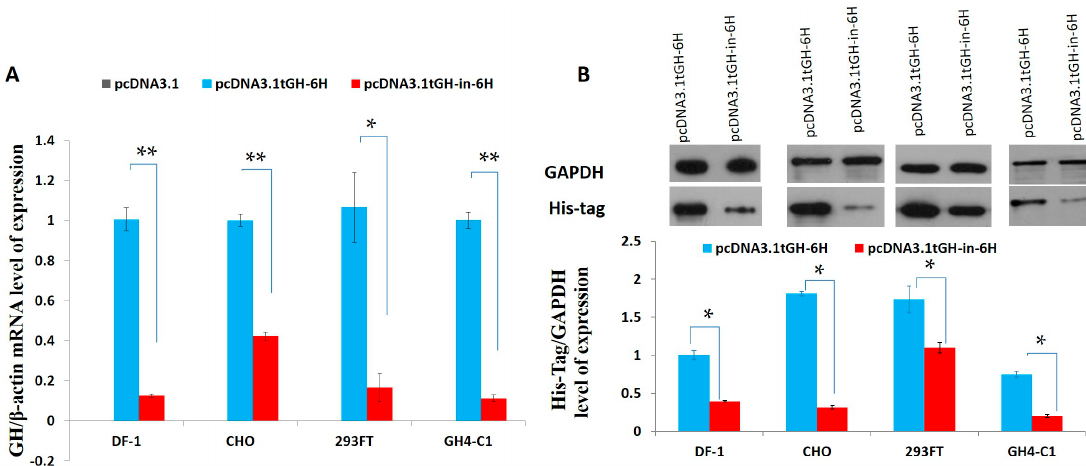
Figure 5. GH gene mRNA and protein expression following the transfection of four cell lines. ( A ) The mRNA expression level with qRT-PCR test after the four cell lines were treated with vectors for 48 h. The expression of turtle GH mRNA transfection with pcDNA3.1tGH-in-6H was only 13%, 42%, 17%, and 11% of the pcDNA3.1tGH-6H expression level in DF-1, CHO, 293FT, and GH4-C1, respectively ( p < 0.05); ( B ) The protein expression level with Western blot test after the four cell lines were treated with vectors for 48 h. The expression of turtle GH transfection with pcDNA3.1tGH-in-6H were only 39%, 18%, 63%, and 27% of the pcDNA3.1tGH-6H expression level in DF-1, CHO, 293FT, and GH4-C1, respectively. Data were processed using the statistical software package SAS 9.1.3 (SAS Institute Inc., Cary, NC, USA) and expressed as the mean ± SEM. Variance analysis was operated using GLM procedure, based on at least three replicates for each treatment. * p < 0.05 compared between the two indicated constructs; ** p < 0.01 compared between the two indicated constructs.